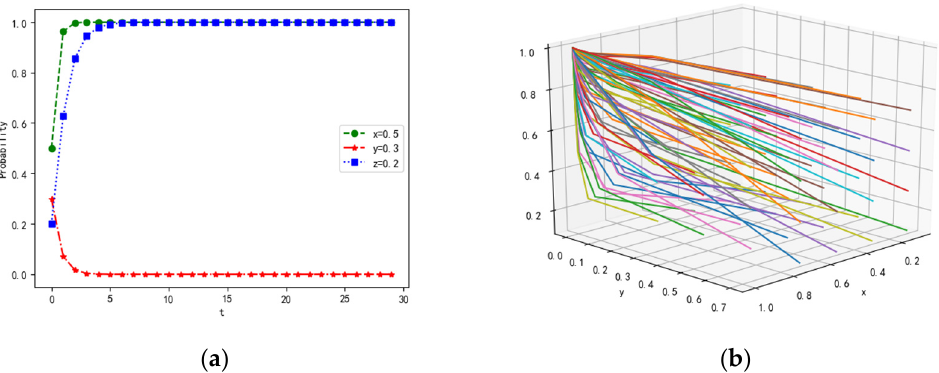
Figure 6. Evolutionary results of p 5 ( 1,0,1 ) shown under a corresponding constraint condition, ( a ) represents the conver- gence of probability with time, and ( b ) shows the results of dynamic simulation in three dimensions.